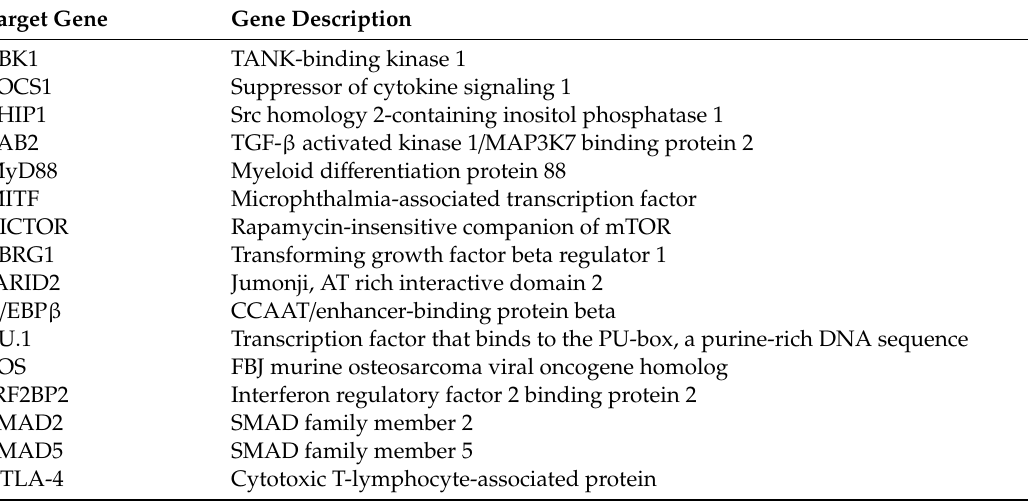
Table 1. The potential target genes of